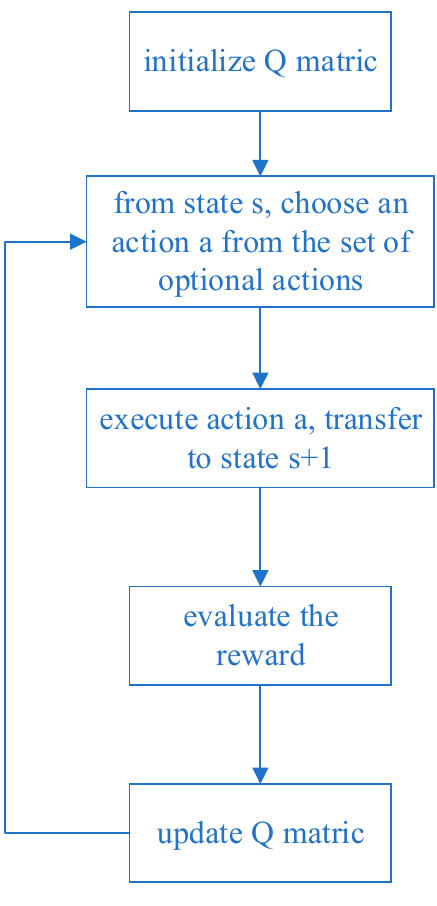
Figure 4. Q-learning algorithm flow chart.